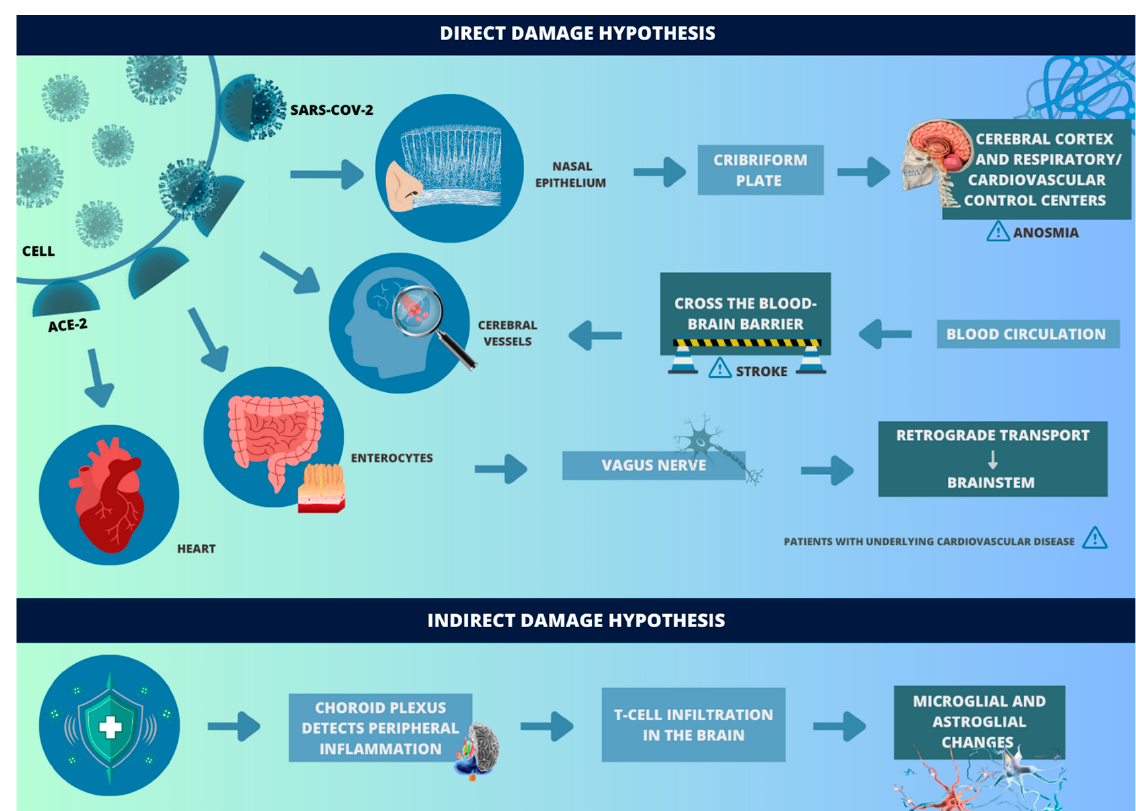
Figure 1. Hypothesis of direct and indirect damage by SARS-CoV-2. (REFERENCE: elaborated by the authors, based on Song J et al. [11], Hamming I et al. [12], Meinhardt J et al. [13], Achar A et al. [14], Awogbindin IO et al. [15], Yang AC et al. [16], Bourgonje AR et al. [17] and Chang WT et al [18].